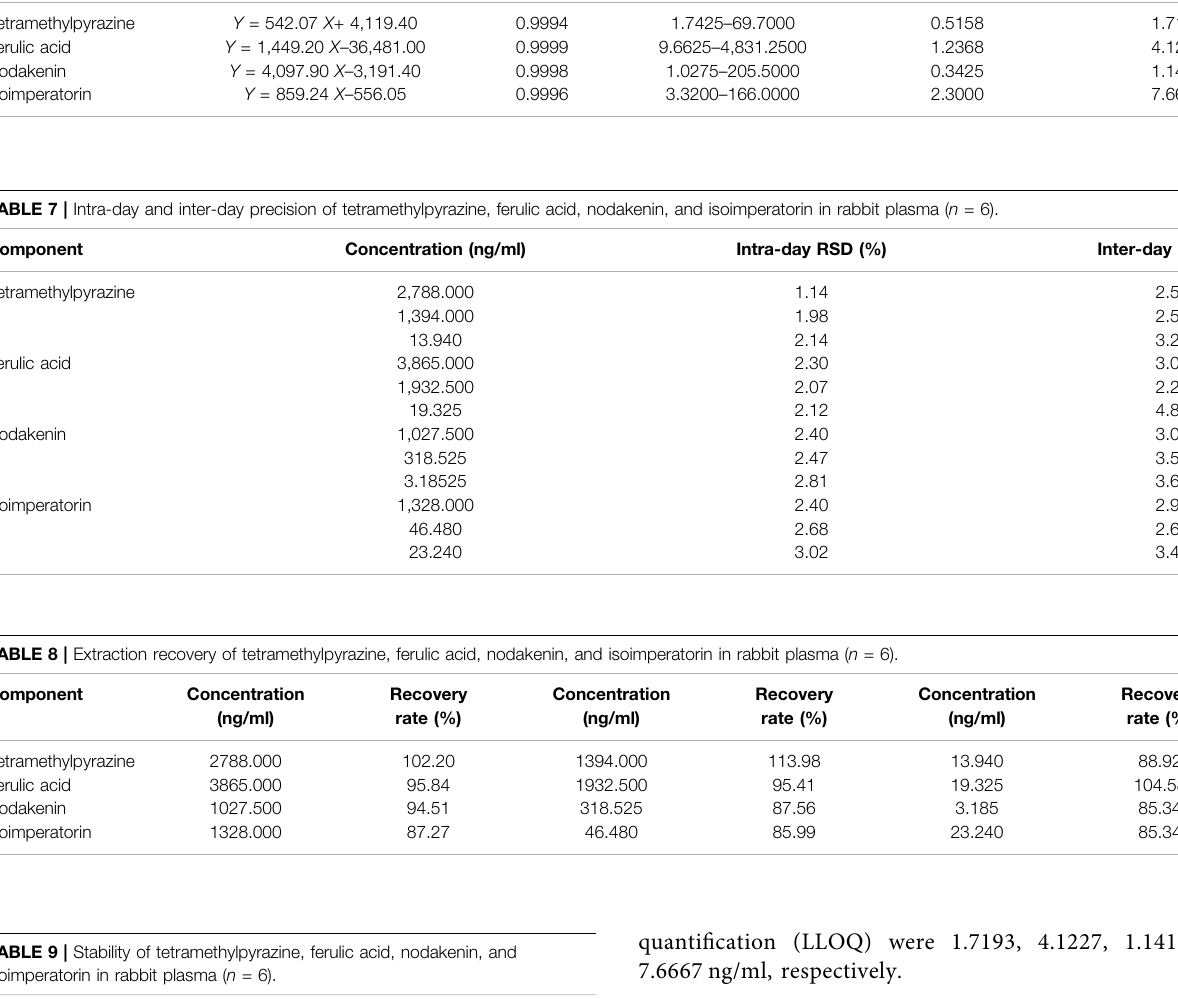
TABLE 9 | Stability of tetramethylpyrazine, ferulic acid, nodakenin, and isoimperatorin in rabbit plasma ( n = 6).